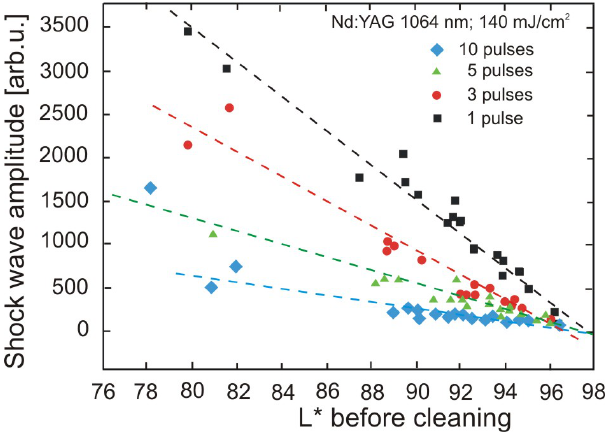
Figure 45. Shockwave amplitude after successive laser shots (as indicated) at the conditions as indicated, as a function of density of the deposited soiling. Lower L * denotes higher soiling density.